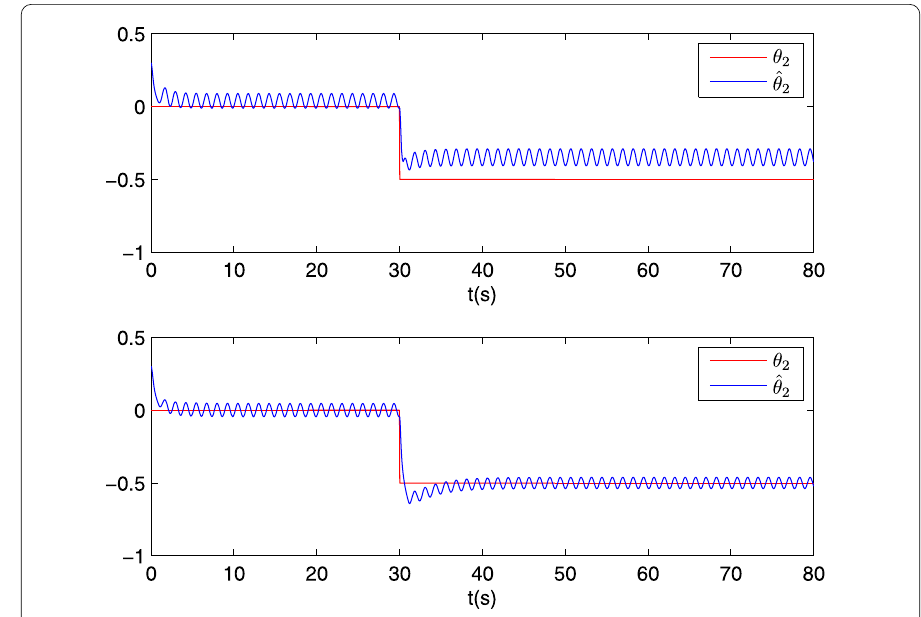
Figure 4 Actuator fault parameter θ 2 ( t ) and its estimation. The red line denotes state θ 2 ( t ) while the blue line denotes its estimation. The lower part is the result obtained using method proposed in this paper, while